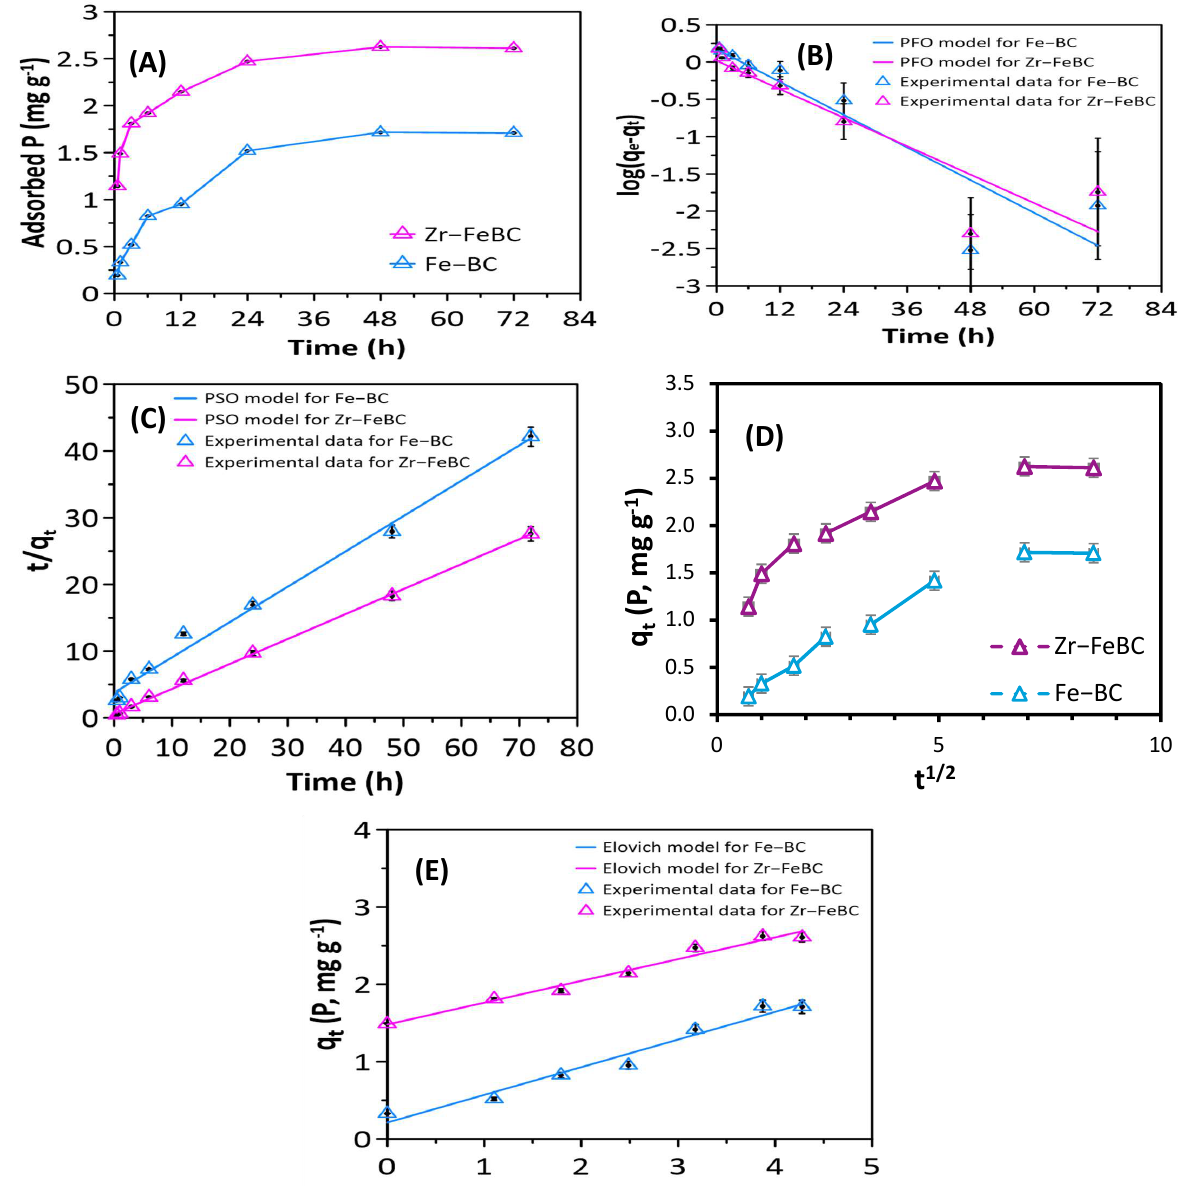
Figure 2. Effect of time on adsorption capacity of P by modified biochars ( A ), kinetic models for P adsorption: ( B ) pseudo- first order (PFO), ( C ) pseudo-second order model (PSO), ( D ) intraparticle diffusion model and ( E ) Elovich model (initial P concentration was 10 mg L –1 , biochar concentration was 2.0 g L –1 at 22 ± 0.5 °C).